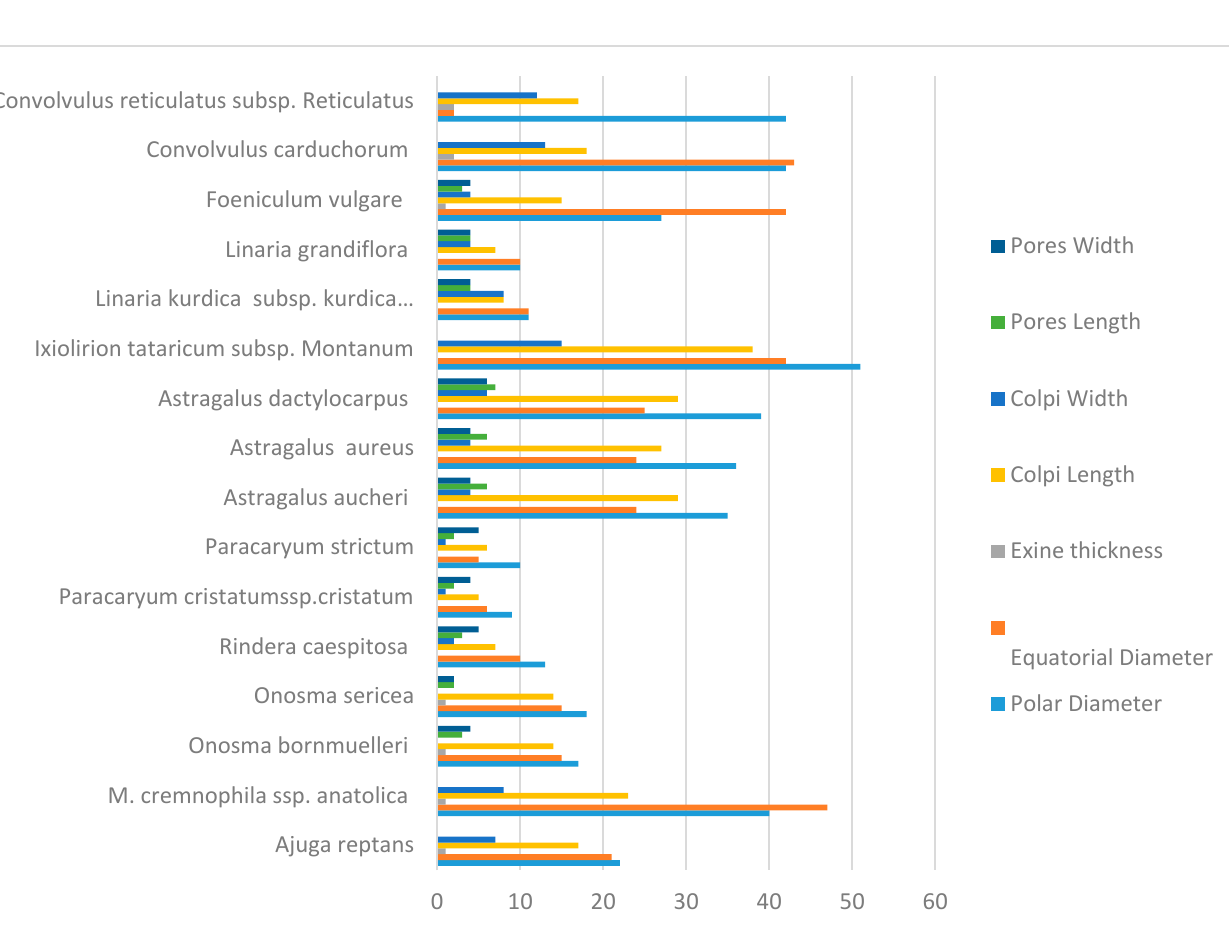
ma tt er was marked by applying a drop of glycerin jelly. Each specimen received 4–5